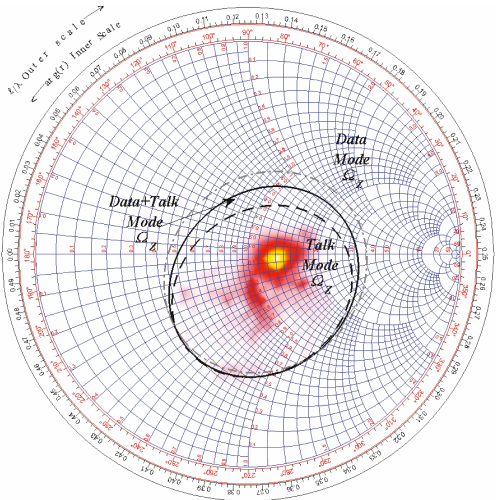
Figure 9: Comparison of talk, data, and fi nal uncertainty impedance ellipse in UTRA/FDD LTE B3 band for a T- monopole